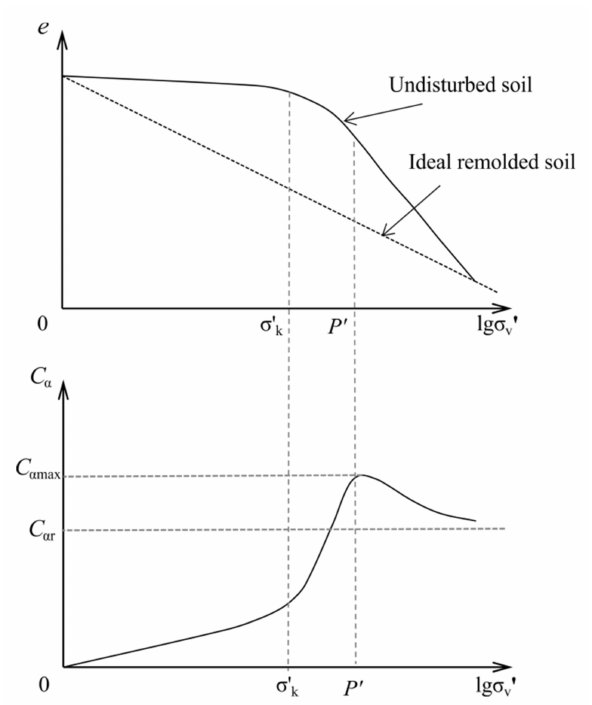
Figure 15. Variation of secondary compression coe ffi cients with vertical e ff ective